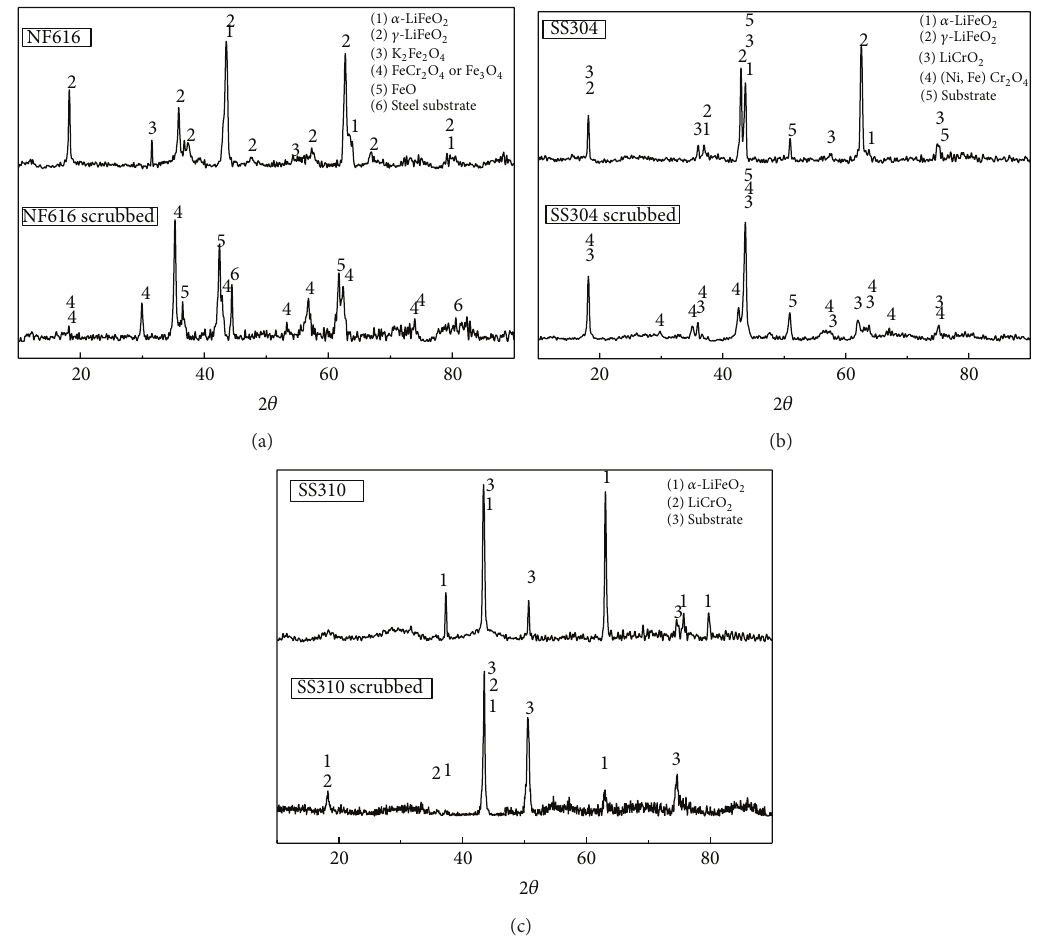
Figure 7: XRD patterns for corrosion products on P92 (a), SS304 (b), and SS310 (c) after 120h of immersion in molten carbonate.